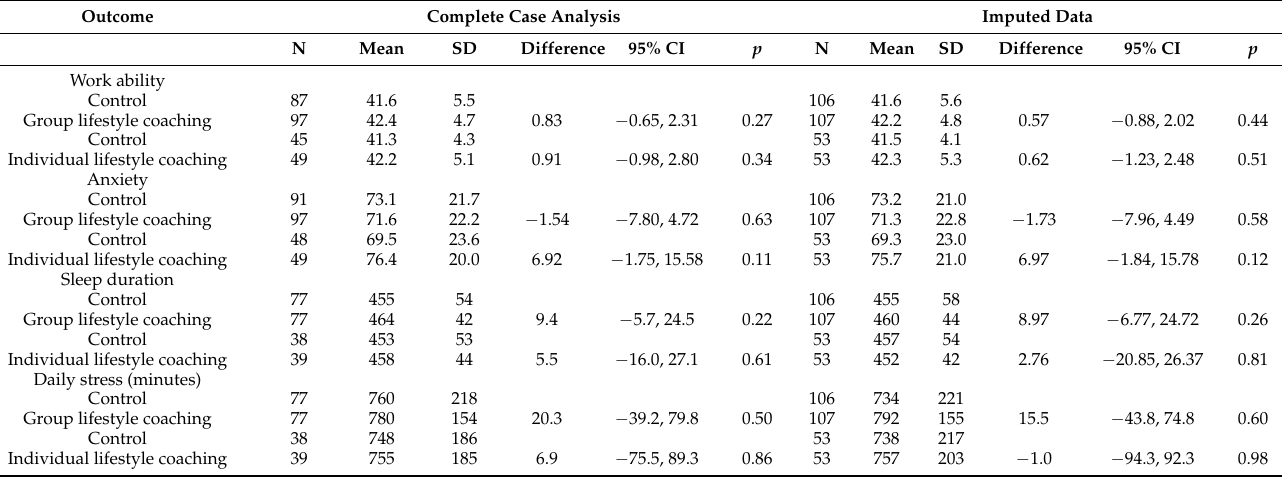
Table 3. The effects of group and individual lifestyle coaching on work ability, anxiety, sleep duration, and daily stress (continuous